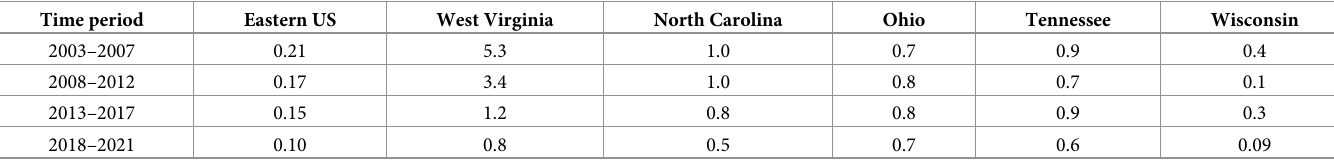
Table 2. Cumulative incidence per 100,000 population of La Crosse virus neuroinvasive disease for the eastern United States (US) and the five states that reported the most cases from 2003–2021. Time period Eastern